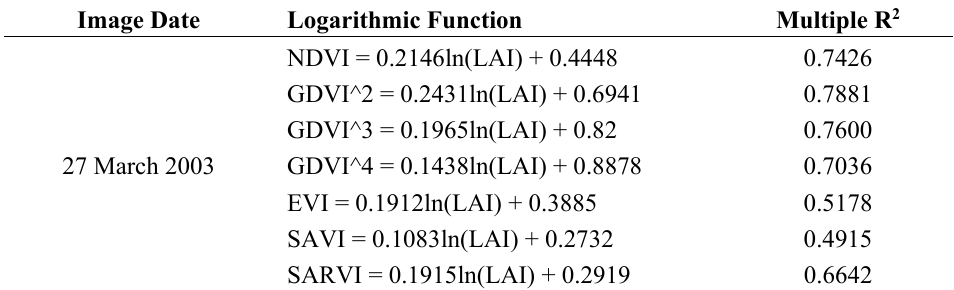
Table 6. Calibrated biome mean-based logarithmic relationships between the vegetation indices and